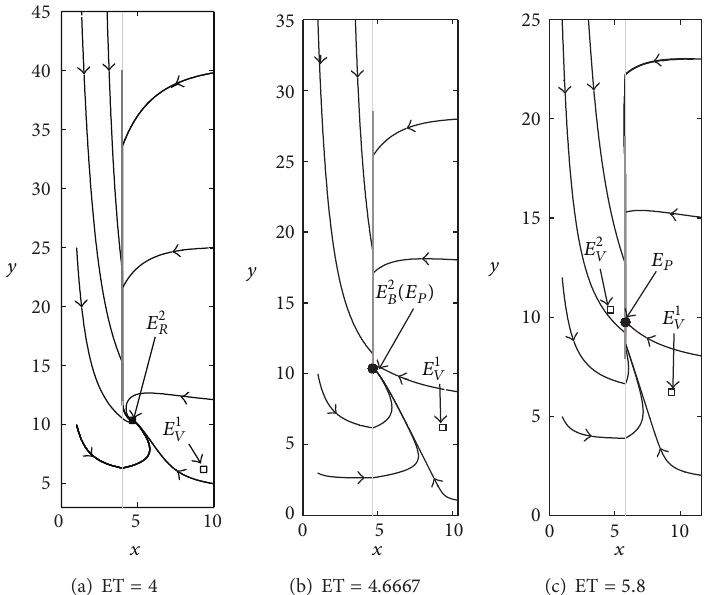
Figure 4: Boundary node bifurcation for Filippov system (3). The parameter values are fixed as follows: 𝑎 = 0.7 , 𝑏 = 0.6 , 𝑟 = 1.5 , 𝑘 = 12 , = 0.25 , and 𝑞 = 0.1 𝛽 = 0.5 , 𝛿 = 0.25 , 𝑞 1 2